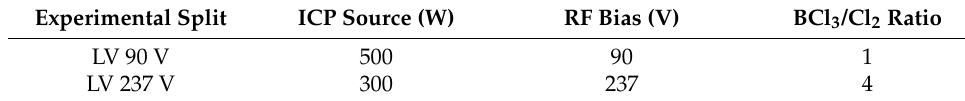
Table 1. ICP-RIE etching split table.